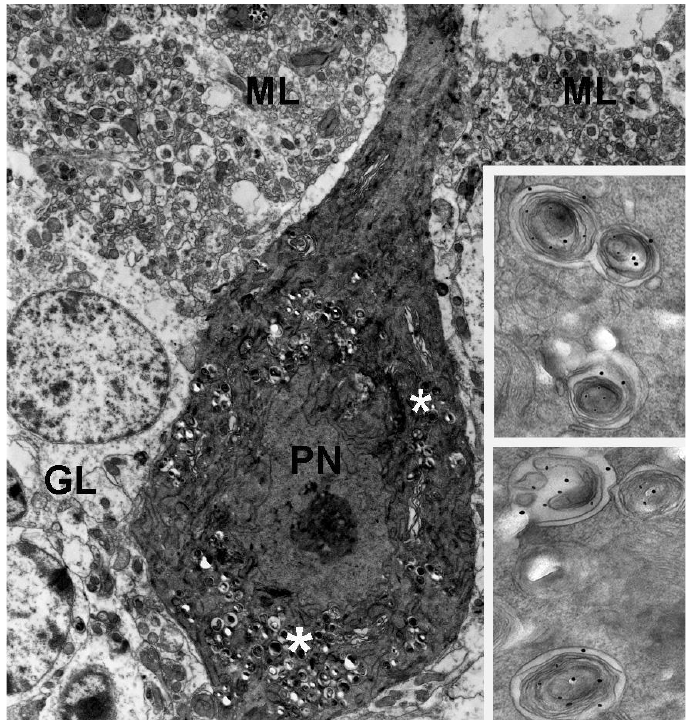
FIGURE 2. Purkinje neuron in the cerebellum of Npc1 mouse. Note the accumulation of secondary lysosomes in the cell body. The areas marked by the asterisks are enlarged in the inserts. Note that secondary lysosomes contain gold particles indicative of BCL-2 immunoreactivity. Abbreviations: GL = granular layer of the cerebellar cortex; ML = molecular layer of the cerebellar cortex; PN = Purkinje neuron. Original magnification  6,000; inserts 